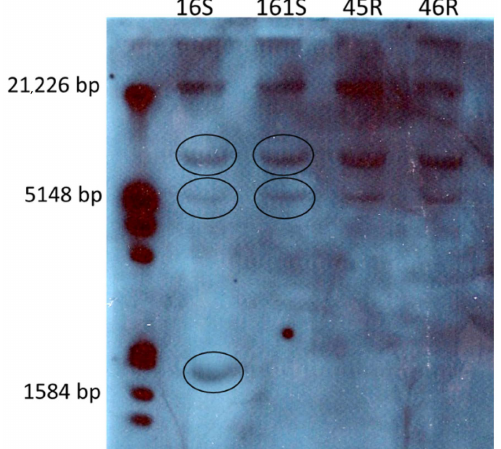
Figure 3. Southern blotting analysis on ALS gene of E. crus-galli (16S) and E. oryzicola (161S, 45R and 46R) genomic DNA extracted from leaf tissue. DNA samples of different populations (reported on the top) were digested with the enzyme HindIII. The numbers on the left show the DIG-labeled molecular ladder. Circles indicate the copies of the ALS gene in the different